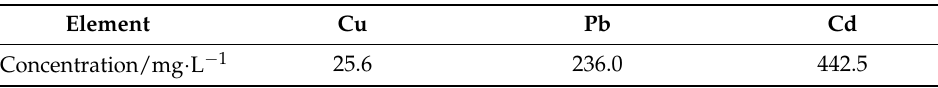
Table 2. The impurity ion content in the leaching solution.